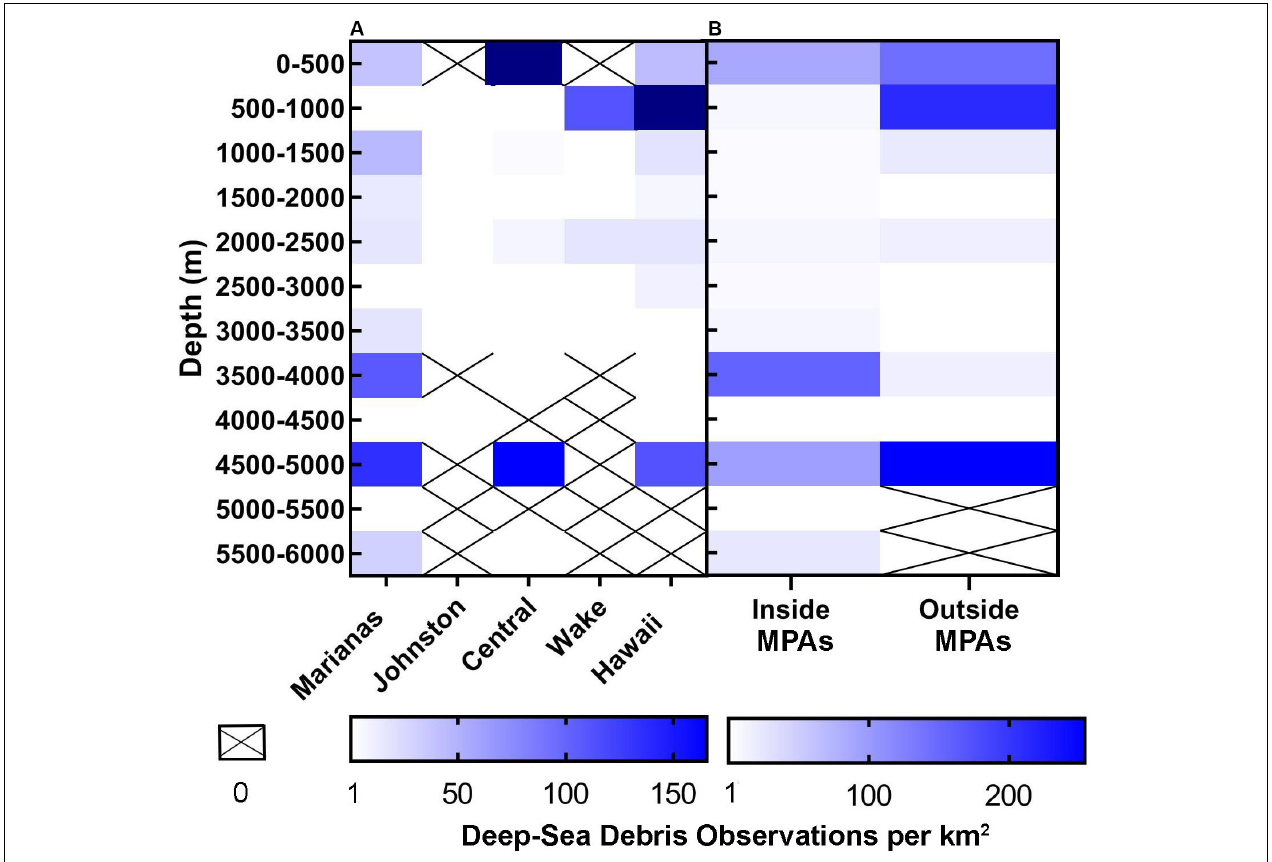
FIGURE 2 | Densities of deep-sea debris by depth observed in the central and western Pacific Ocean. (A) All sites were collapsed into five regions to allow for sufficient data density – “Marianas” (MTMNM and Mariana Islands), “Johnston” (PRIMNM Johnston Atoll only), “Central” (Rose Atoll Marine National Monument, NMS of American Samoa, American Samoa, PIPA, PRIMNM Howland and Baker Unit, PRIMNM Jarvis Island, PRIMNM Kingman Reef, and Palmyra Atoll), “Wake” (PRIMNM Wake Island only), and “Hawaii” (Papah¯anaumoku¯akea MNM and main Hawaiian Islands). It should be noted that the densities observed at 0–500 m in “Central” and 500–1,000 m in “Hawaii” exceeded the scale (both were > 735 items of debris km − 2 ). (B) Debris observations by depth within and outside of marine protected